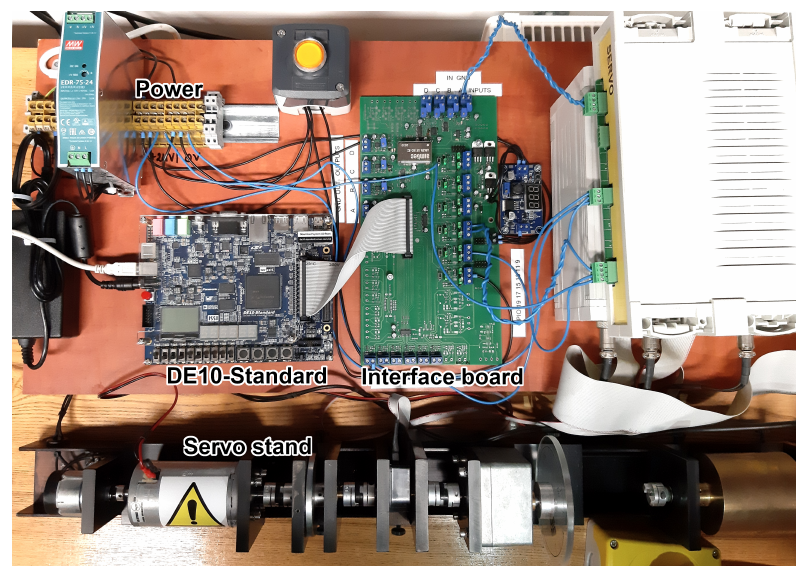
Figure 11. The testing environment, which includes: Power supply, FPGA development board DE10-Standard, Interface board and servo motor—the process of control.